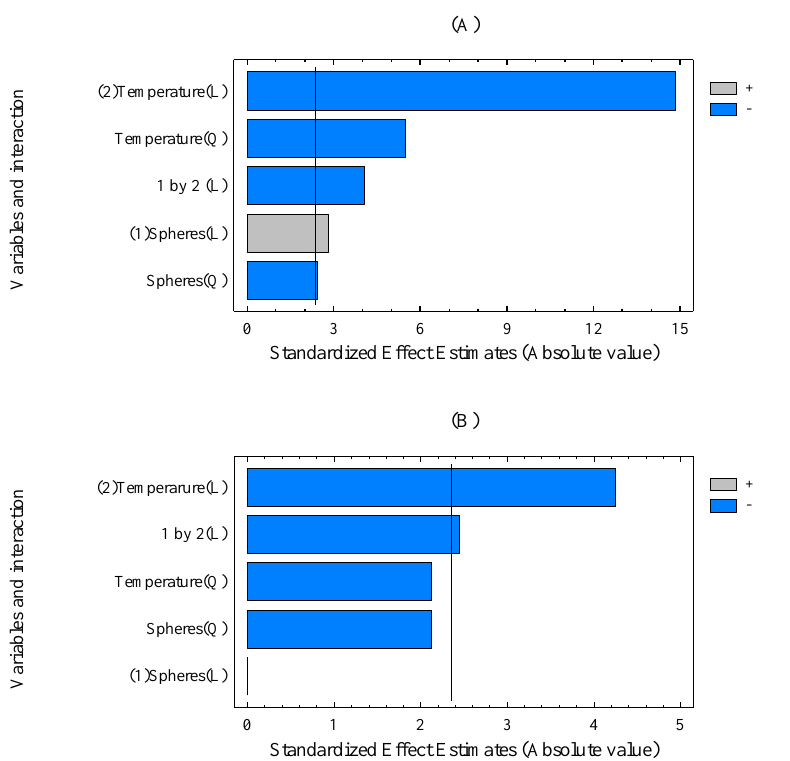
Figure 1. Pareto charts for the effects of the number of spheres (X 1 ) and temperature (X 2 ) on ethanol volumetric productivity ( A ) and ethanol yield ( B ) from simultaneous saccharification and fermentation (SSF) experiments of pre-treated rice straw in the VBM reactor.